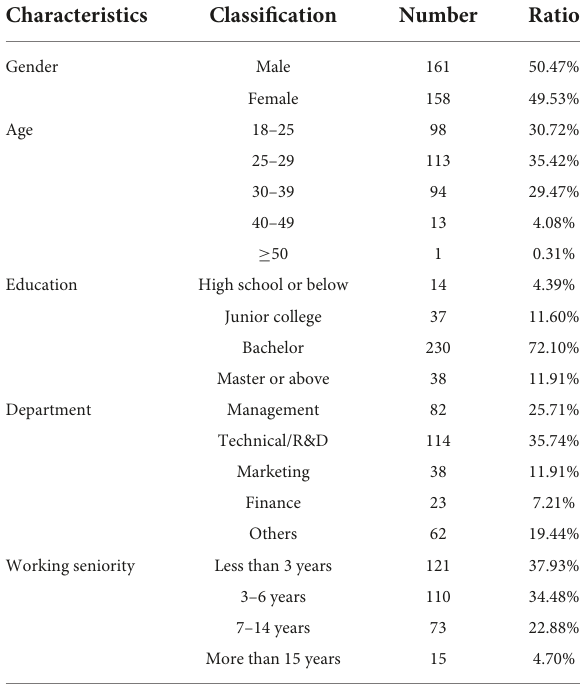
TABLE 1 Statistical characteristics of the sample.